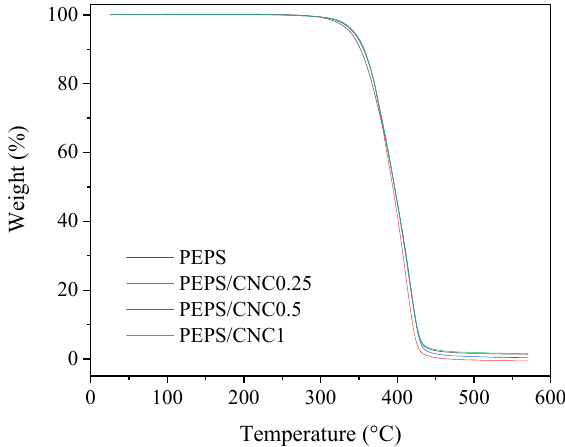
Figure 2. TGA curves of PEPS and PEPS/CNC composites. Although PEPS has the same main chain structure as PES, the presence of methyl as a side group destroys the regularity of the main chain structure. As a result, the crystal- lizability of PEPS is remarkably weaker than that of the PES homopolymer. The DSC cool- ing traces are depicted in Figure 3 for PEPS and PEPS/CNC composites, which were non- isothermally crystallized at a fast cooling rate of 20 °C/min from the crystal-free melt. Un- der this crystallization condition, PEPS did not crystallize, showing no crystallization ex- othermic peak in Figure 3. On the contrary, regardless of CNC content, the three PEPS/CNC composites showed obvious crystallization exothermic peaks during the crys- tallization process, indicating that CNC played an outstanding nucleating agent role and enhanced the crystallization of PEPS. From Figure 3, the melt crystallization temperature ( T mc ) was determined. The T mc values gradually increased from 28.3 °C for PEPS/CNC0.25 to 29.7 °C for PEPS/CNC0.5 and 35.5 °C for PEPS/CNC1, respectively. Similarly, the melt crystallization enthalpy ( Δ H mc ) remarkably increased from 21.9 J/g for PEPS/CNC0.25 to 47.1 and 54.6 J/g for PEPS/CNC0.5 and PEPS/CNC1, respectively. By using the equilibrium heat of fusion of PES (180 J/g) [10], the absolute degree of crystallinity values of the three composites was approximately calculated to be 12.2%, 26.2% and 30.3%, respectively. The obvious increase in both T mc and Δ H mc revealed that CNC remarkably enhanced the melt crystallization of PEPS even at a relatively fast cooling rate of 20 °C/min as an efficient nucleating agent. The effect of CNC on the isothermal melt crystallization kinetics of PEPS was further investigated with DSC in this research. Figure 4a show the plots of relative crystallinity versus crystallization time of PEPS and PEPS/CNC composites at a T c of 71 °C. Due to the small degree of supercooling, PEPS crystallized slowly and required 87.8 min to complete the crystallization, while the total crystallization time for PEPS remarkably became shorter in the composites. For instance, PEPS/CNC0.25 needed 29.6 min to finish the crystalliza- tion, while PEPS/CNC1 even only required 18.2 min at the same T c , suggesting that the higher the CNC content, the shorter the crystallization time. The significantly short crys- tallization time of PEPS/CNC composites indicated that the isothermal melt crystallization of PEPS was also promoted by CNC as an effective nucleating agent.